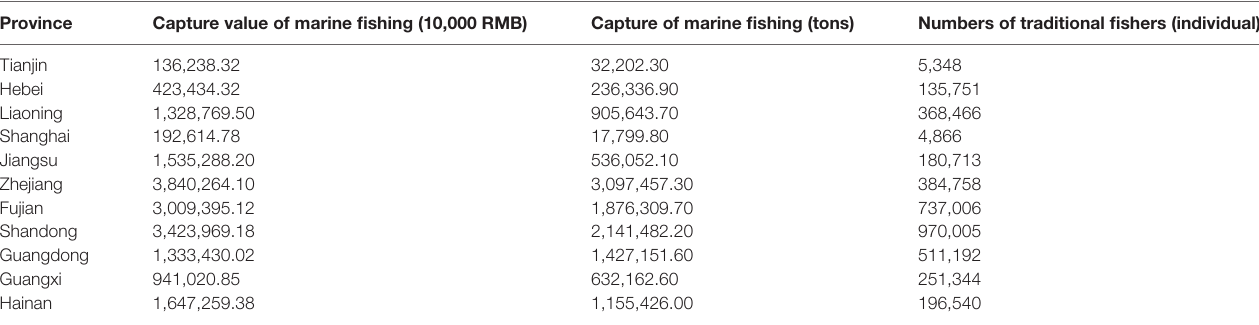
TABLE 2 | Index system of constructing catch shares.